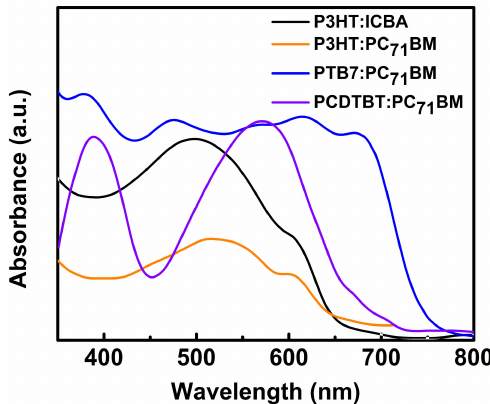
Figure 7. Absorption spectra of some widely used active materials in OSCs for indoor